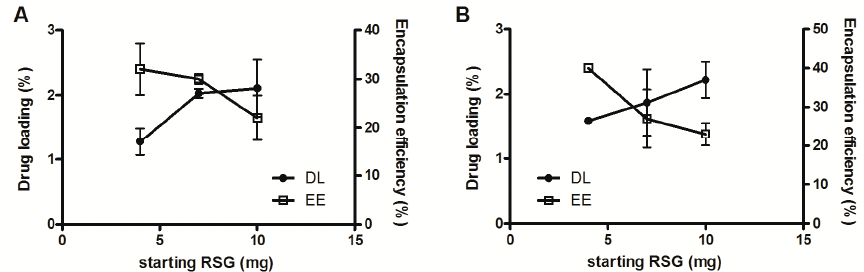
Figure 1. RSG drug loading (DL, left axis) and encapsulation efficiency (EE, right axis) in nanoparticles prepared with acetonitrile ( A ) or acetone ( B ) by nanoprecipitation as a function of RSG starting concentration. Table 4. RSG encapsulation efficiency (EE) and drug loading (DL) in different NP formulations prepared by emulsion-evaporation or nanoprecipitation, with different RSG starting amounts (4, 7,